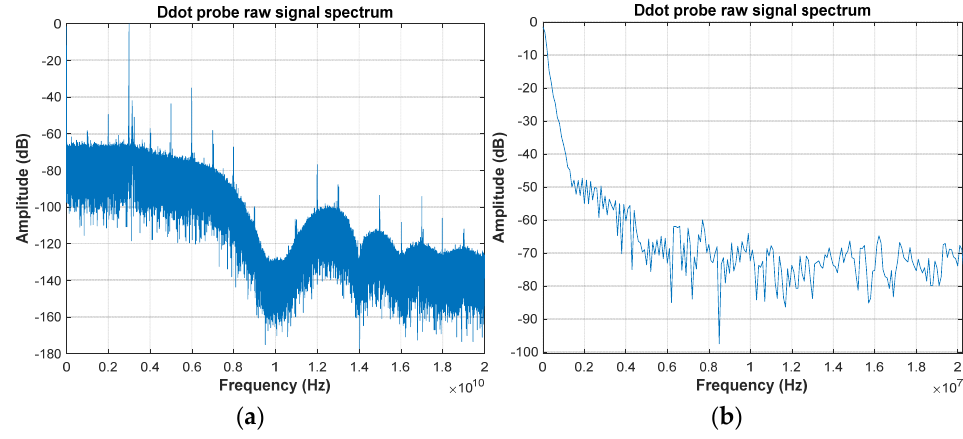
Figure 14. Electric field raw signal frequency spectrum, full bandwidth from 0 to 20 GHz ( a ), limited bandwidth 0 to 20 MHz ( b ).